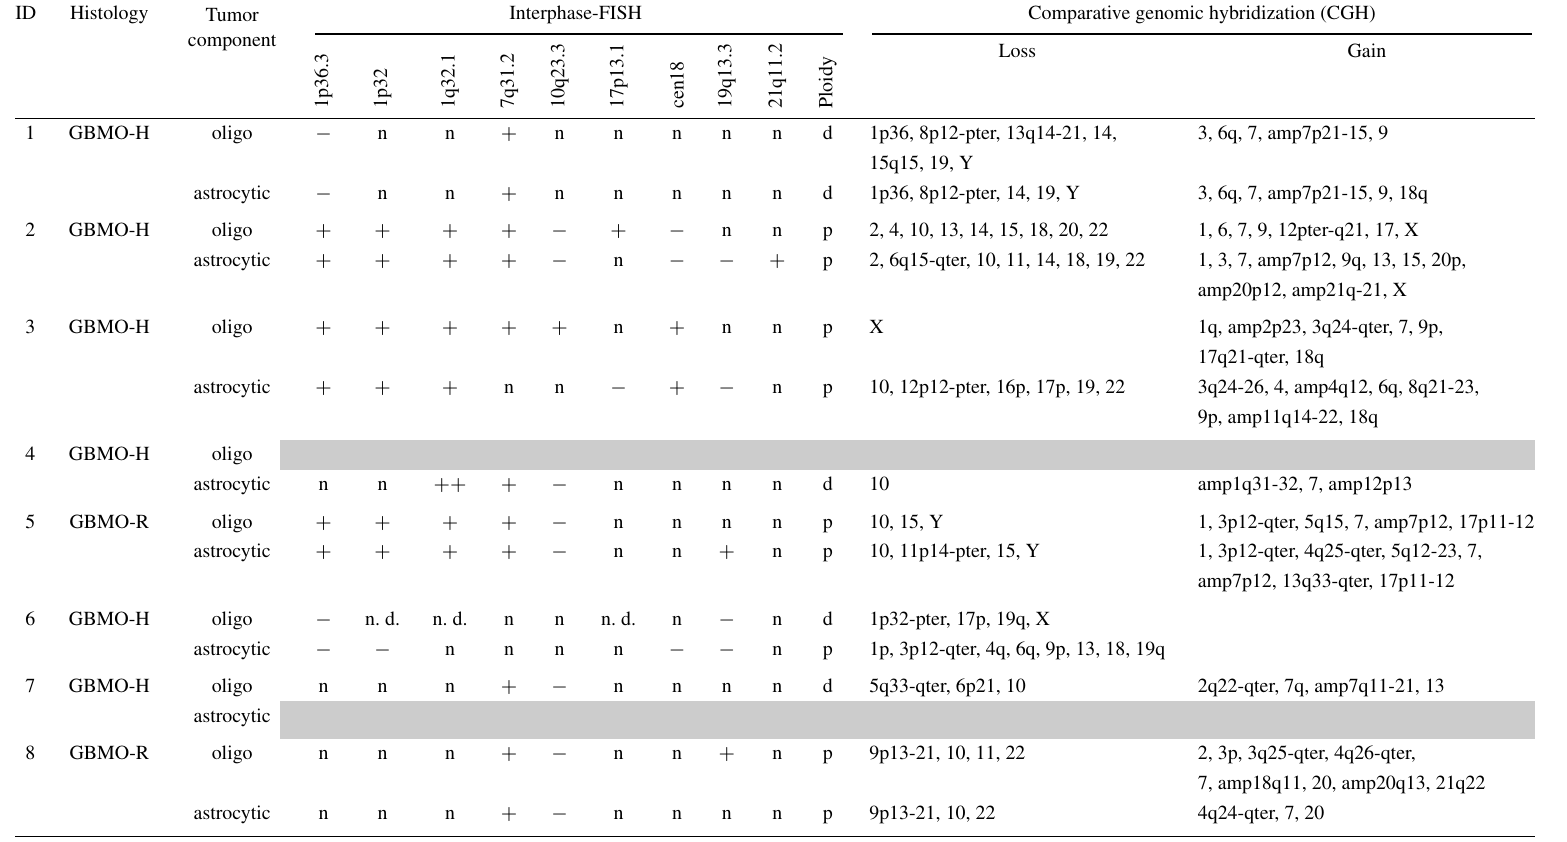
Interphase-FISH and CGH results of GBMOs and